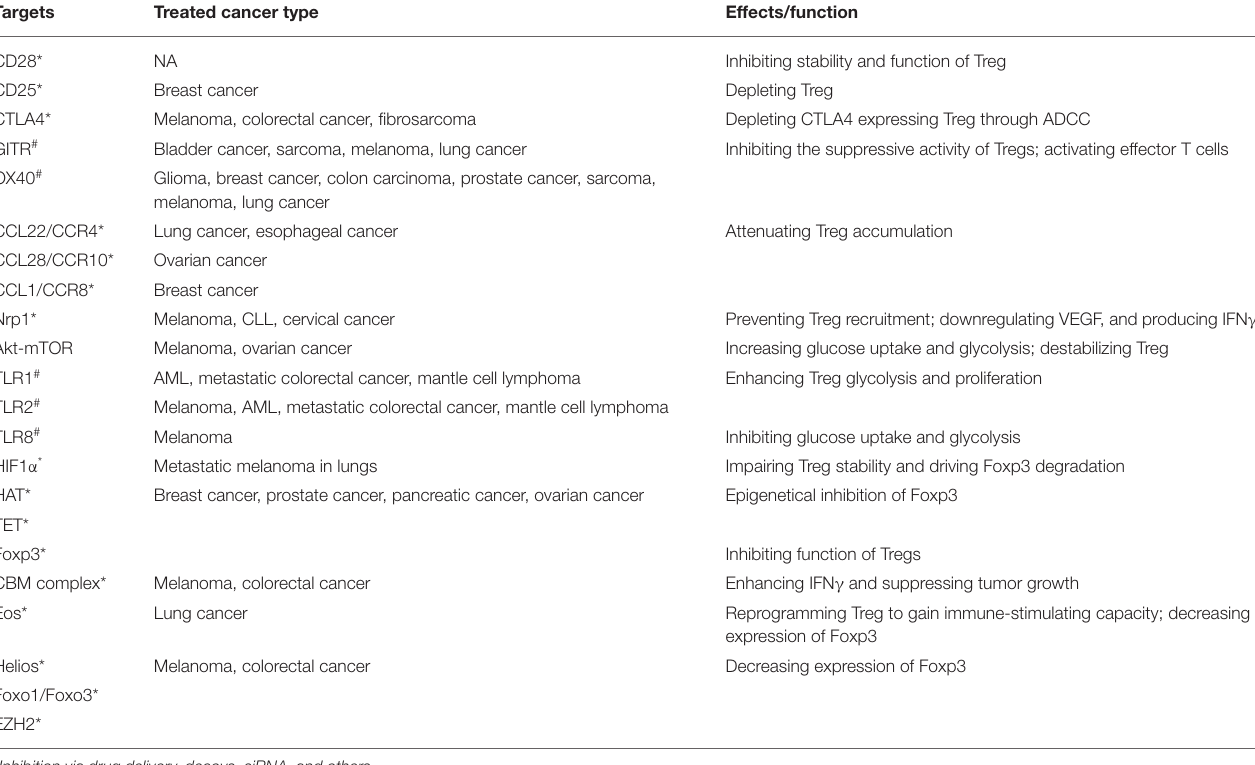
TABLE 3 | Therapeutic strategies targeting regulatory T cell (Treg) for cancer therapy.